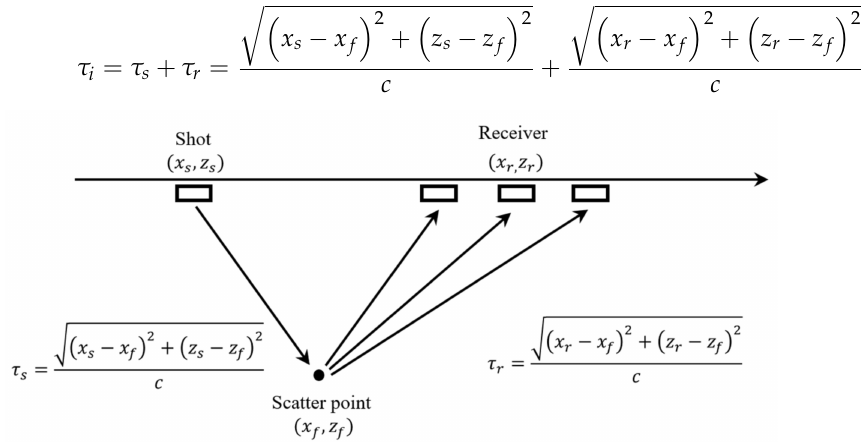
Figure A1. Time delay